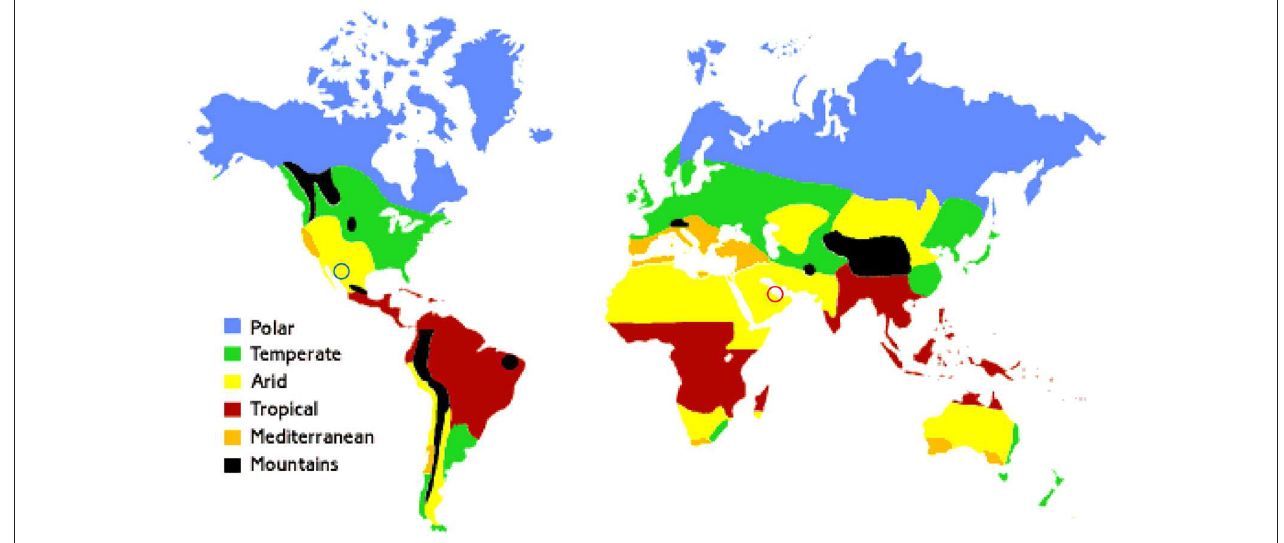
FIGURE 1 | World Climate Zones showing the (red circle) State of Qatar having the same climate zone as the (blue circle) desert in Southern California (Internet GeographyWorld Climate Zone, 2015 ).